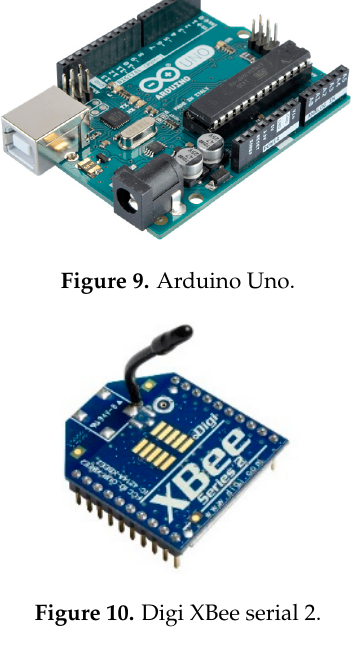
Figure 11. The indoor monitoring device.